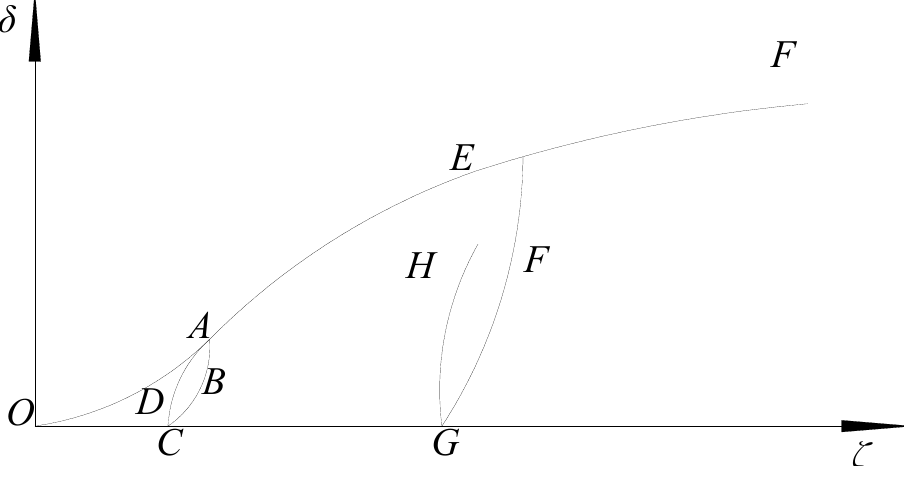
Figure 21. Geotechnical deformation mechanism.